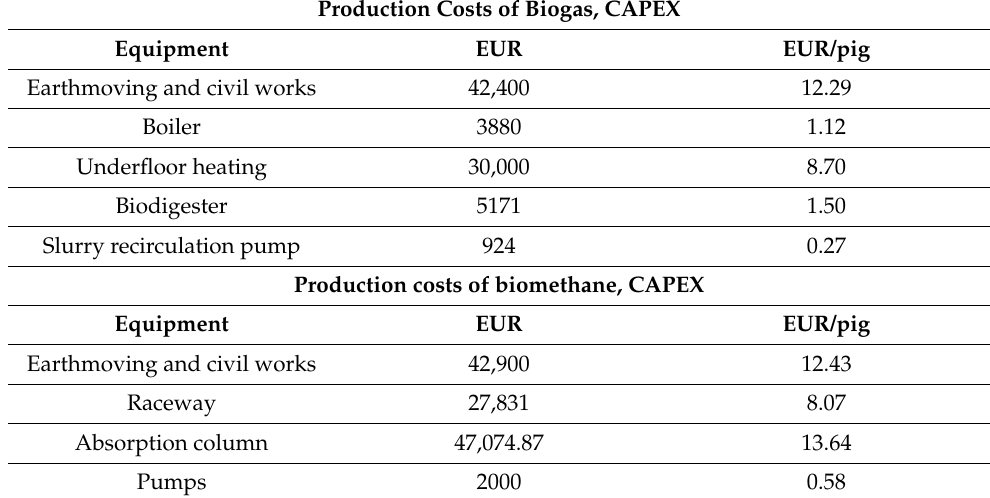
Table 4. Production costs of biofuels, LIFE SMART